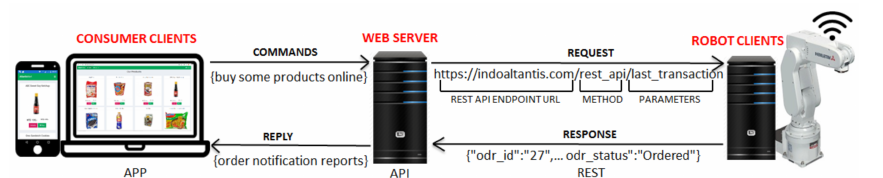
Figure 3. The AIoT with REST API mechanism, each request would be responded to a set of the last transaction